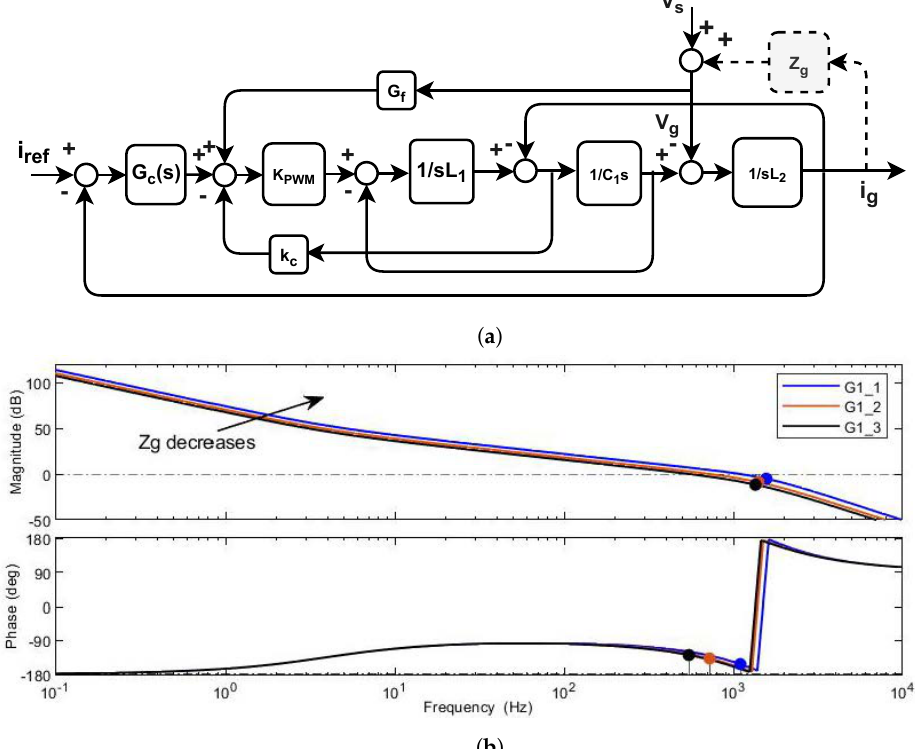
Figure 3. Strategy 1: Proportional based grid voltage feedforward ( a ) Average switch control model. ( b ) Open loop system